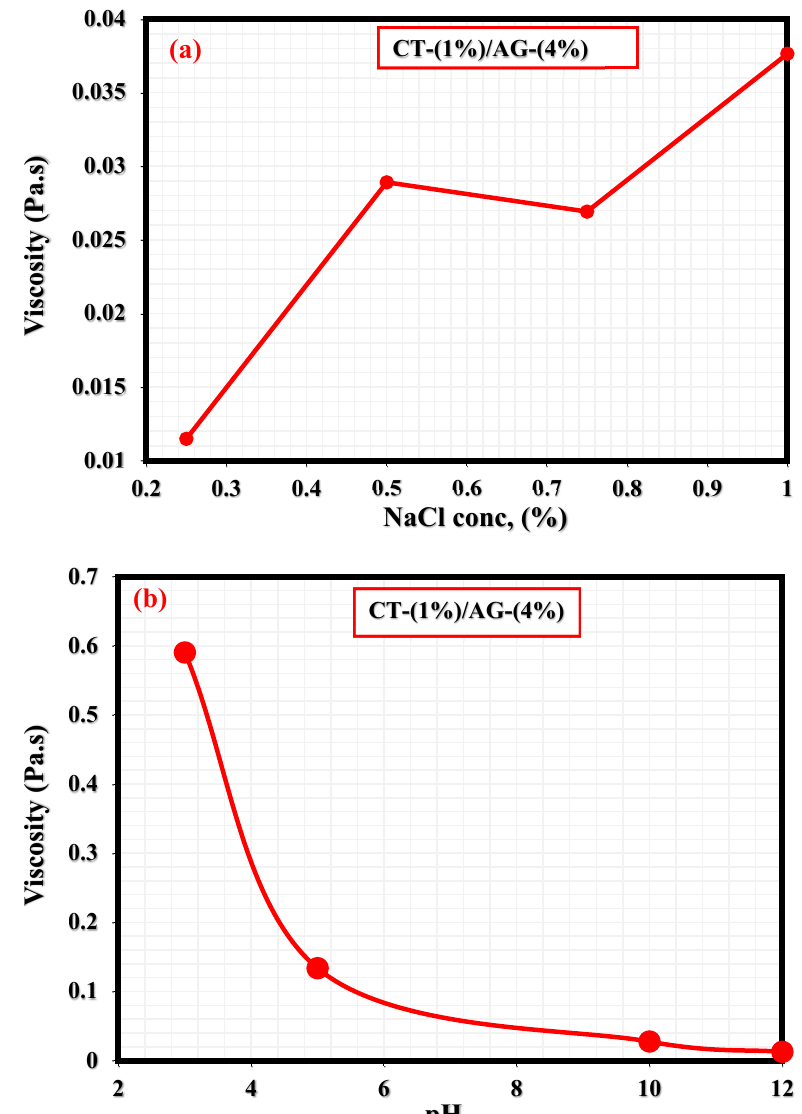
Figure 9. ( a ) Viscosity dependence of 1%-CT/4%-AG emulsion at various NaCl concentrations. ( b ) Viscosity dependence of 1%-CT/4%-AG emulsion under pH at constant shear rate.